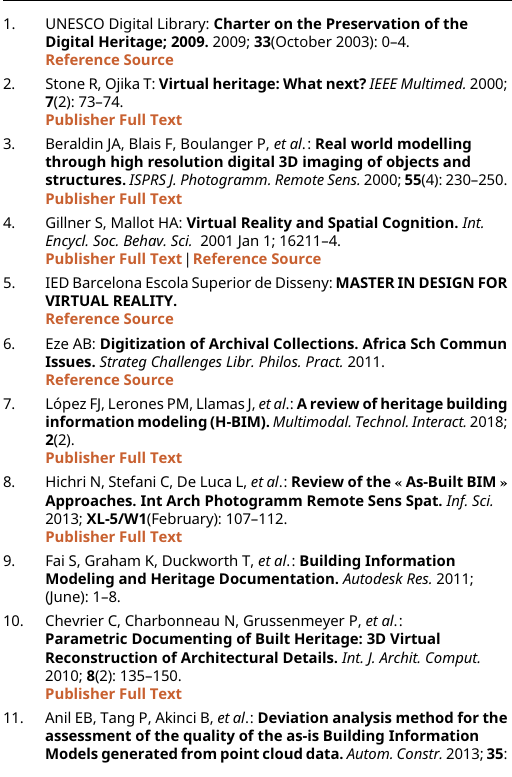
(cid:129) XBOX E.png (A figure shows navigating the HBIM model on the Enscape3D platform by using Microsoft Xbox One Wireless